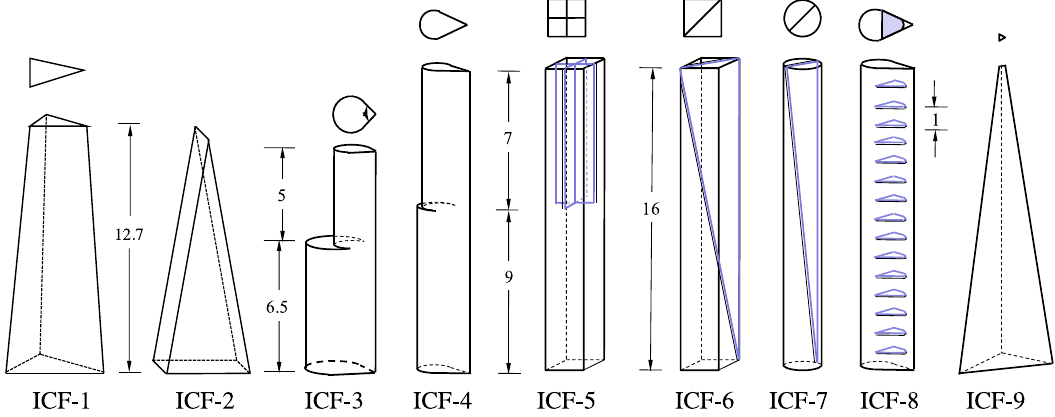
Fig. 2 ICF test cells. Wire model sketches of ICF test cells with dimensions in